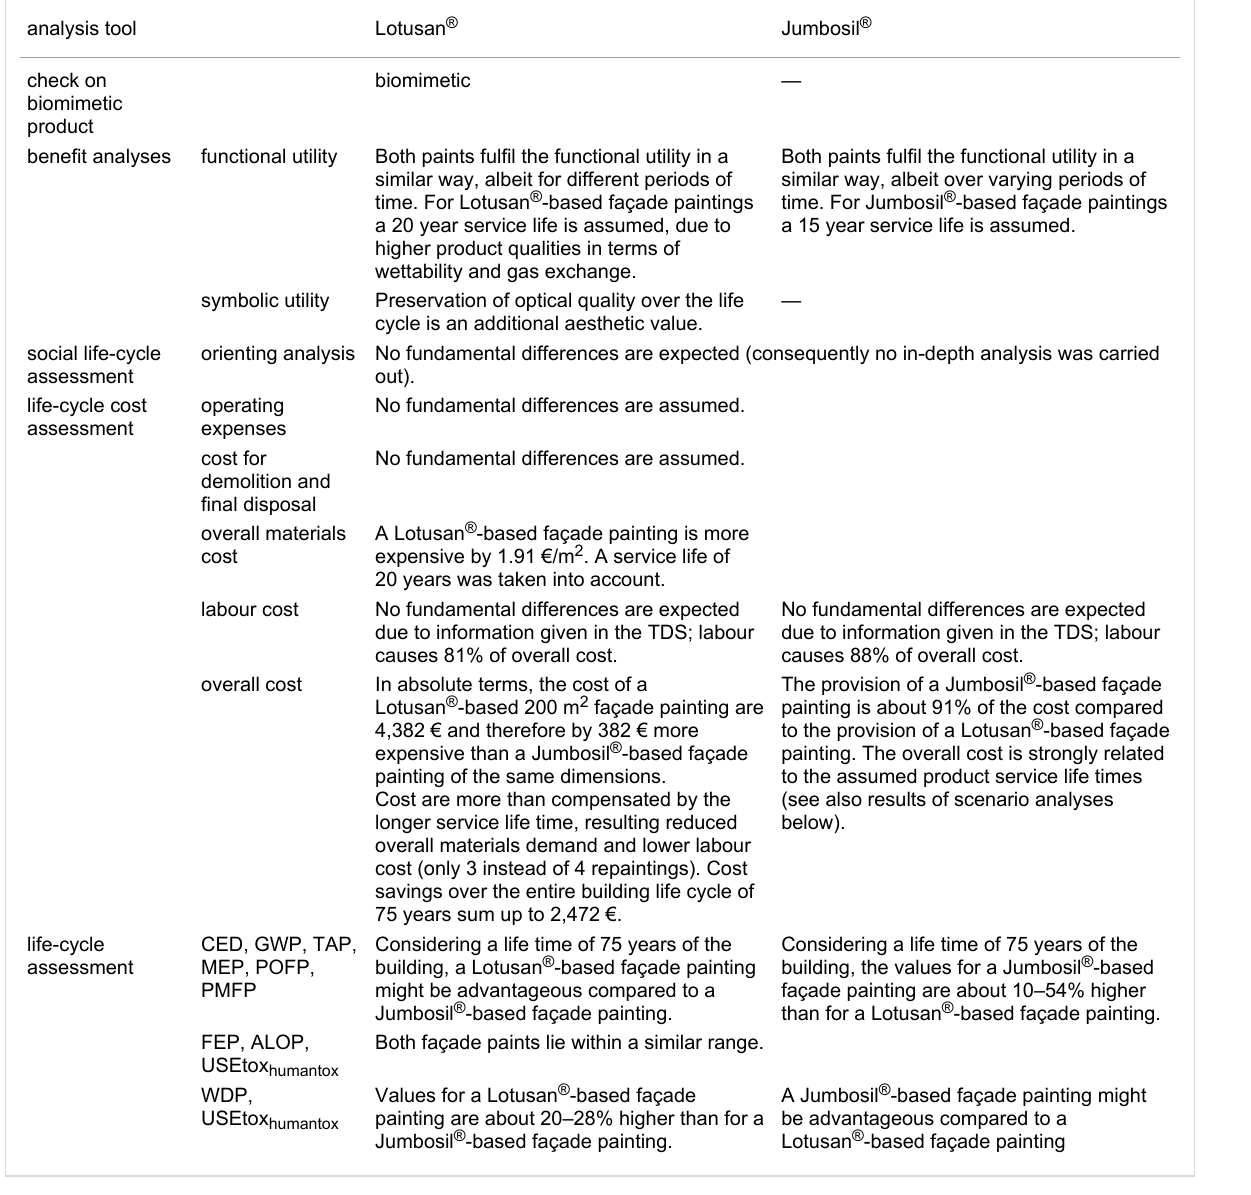
Table 4: Overview of the results for the individual analyses carried out within the product sustainability assessment. analysis